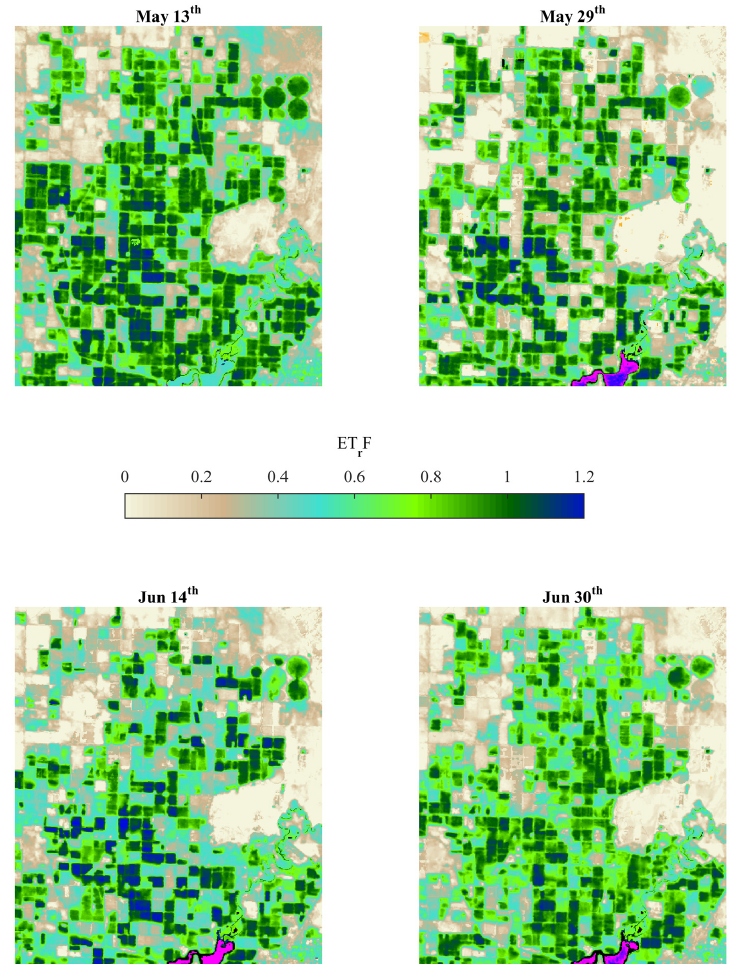
Figure 3. ETrF maps using METRIC model and Landsat 7 ETM+ images for the area of study. Note the absence of gaps in the maps due to the use of the natural neighboring interpolation technique on the original DN bands. Water 2016 , 8 , 167